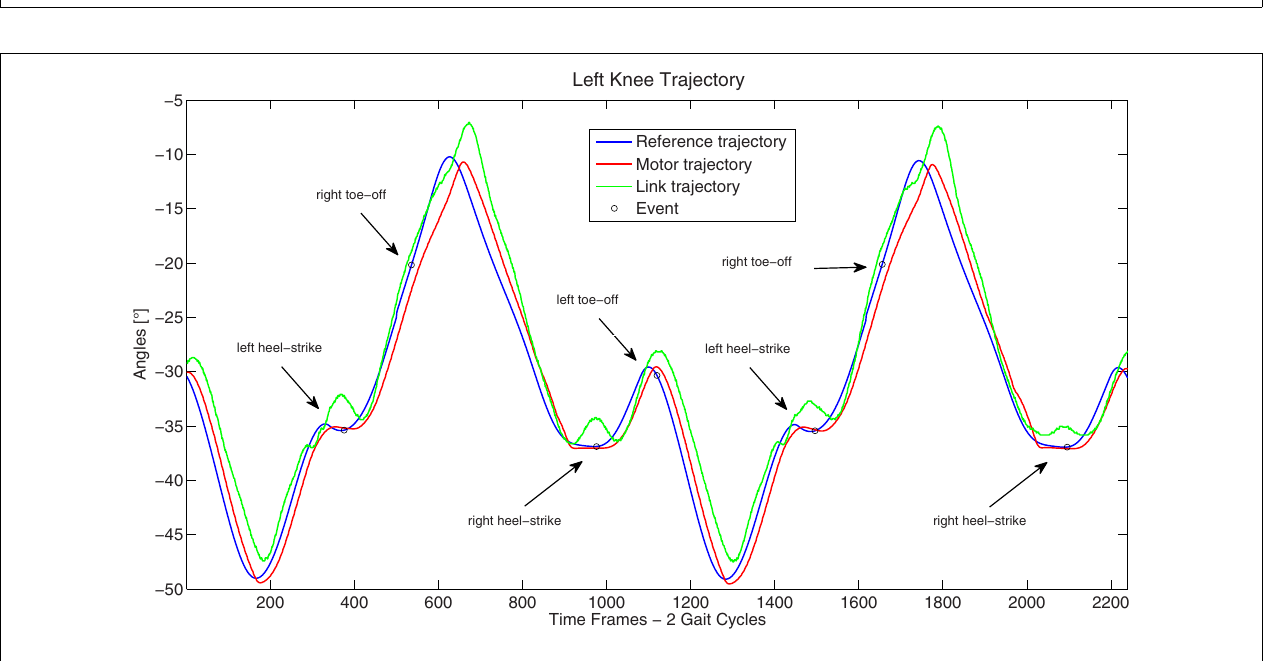
respectively.The total lower body weight is 17.3kg, with each leg weighing approximately 5.9kg, and the waist section, including the hip flexion motors, weighing 5.5kg.The leg of COMAN incorporates two series elastic (SEA) actuation units, which are placed at the knee flexion and the ankle dorsiflexion joints.